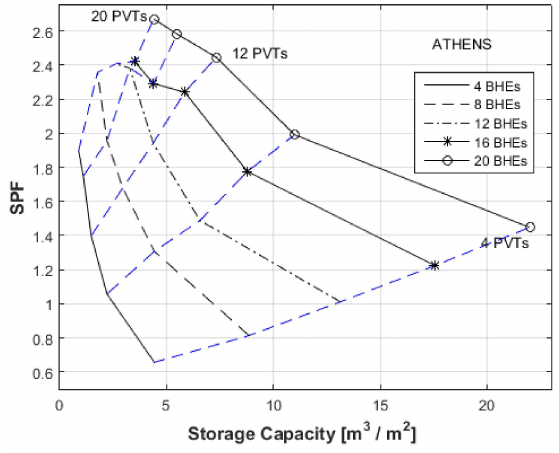
Figure 7. Annual seasonal performance factor as function of the storage capacity for Athens.